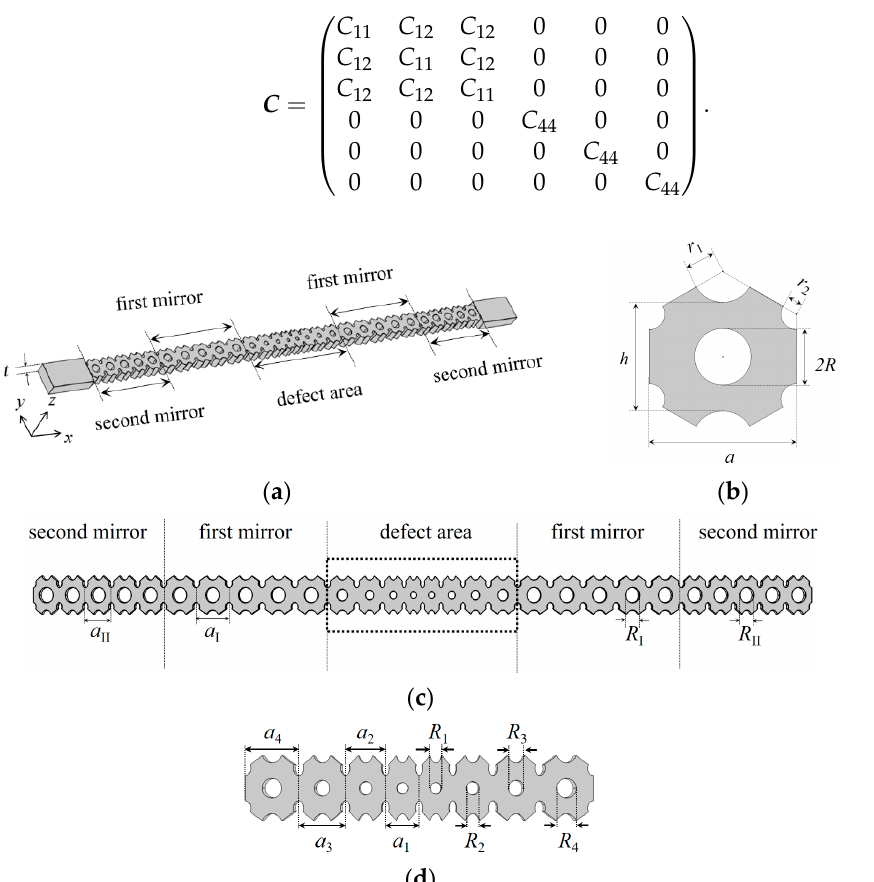
Table 1. Geometric parameters of the optomechanical crystal.